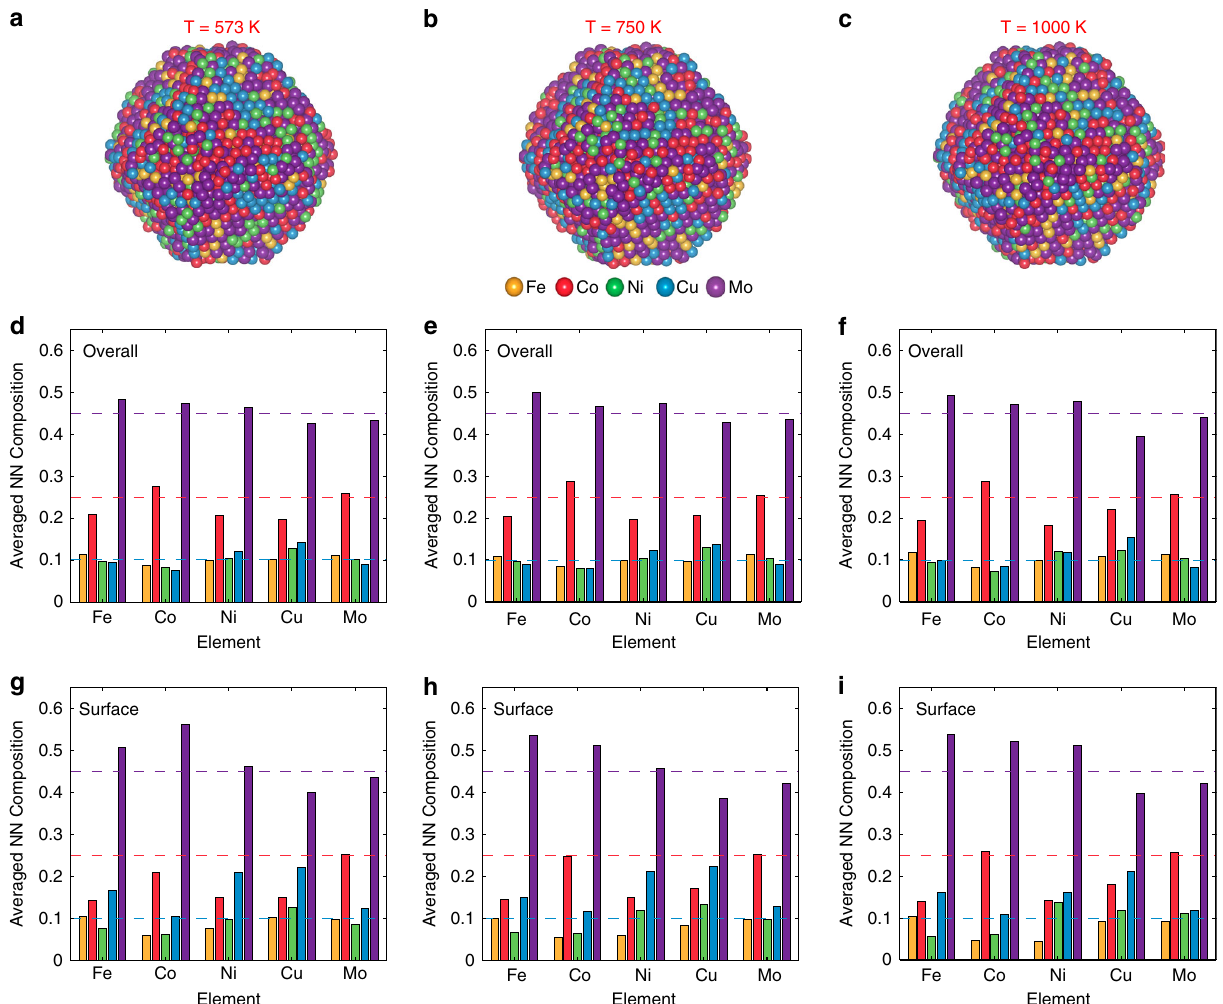
Fig. 8 Atomic structure of HEA catalysts. Atomistic model of HEA-Co 25 Mo 45 nanoparticle predicted by using MC simulations at different temperatures: a 573K; b 750K; and c 1000K. The composition of the fi rst-nearest neighbor lattice sites around a speci fi c element type averaged over ( d – f ) all atoms and ( g – i ) surface atoms in the corresponding nanoparticle. The dashed lines represent the nominal composition of the nanoparticle (Co 0.25 Mo 0.45 Fe 0.1 Ni 0.1 Cu 0.1